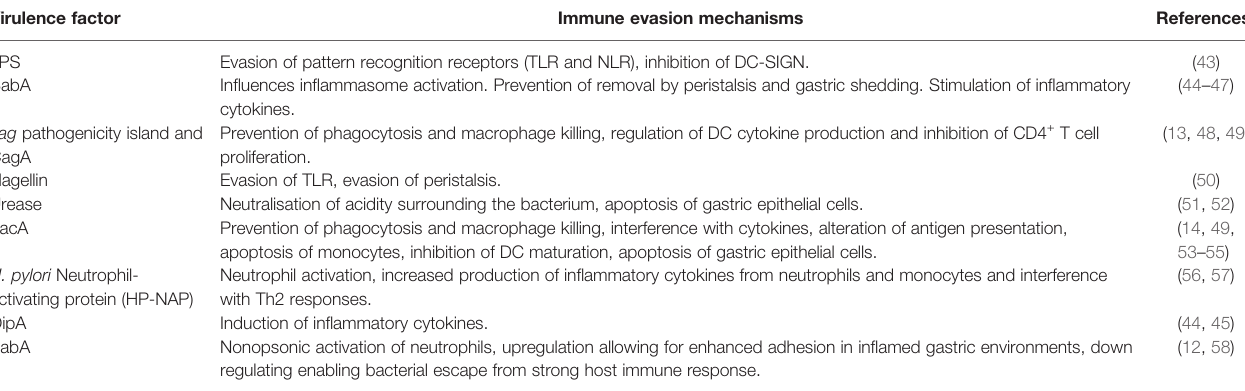
TABLE 1 | Effect of H. pylori virulence factors on the immune